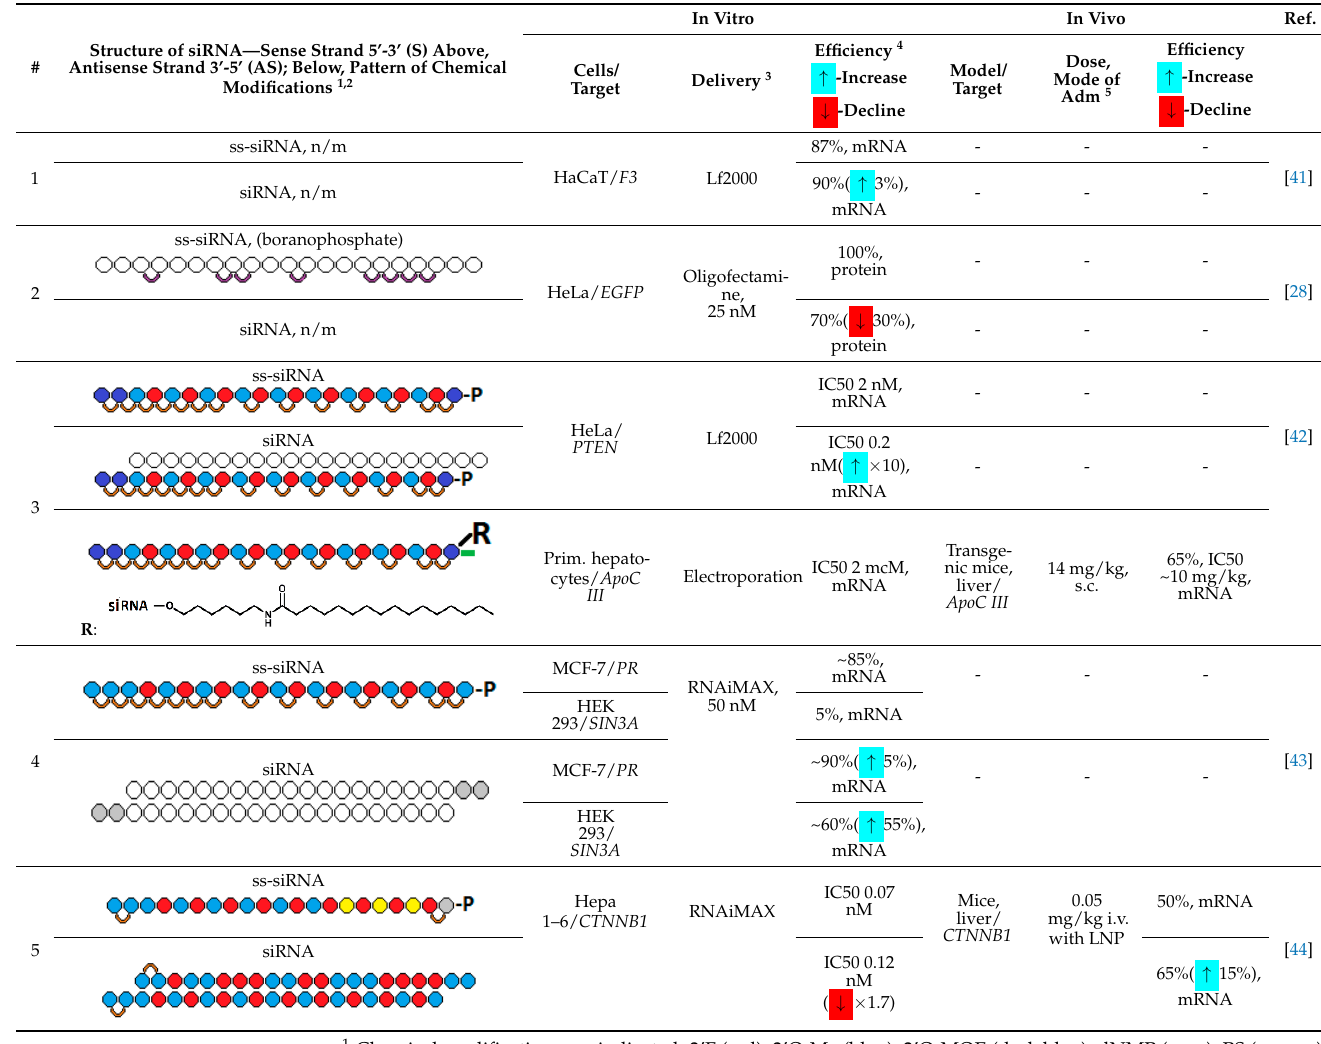
Table 1. Structural modifications of ss-siRNA.